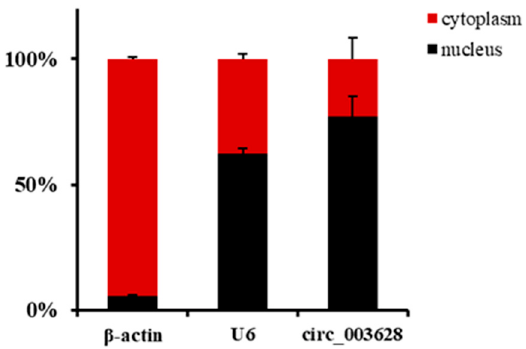
Figure 2. The localization of circ_003628, β -actin and U6 in nuclei and cytoplasm of goat skeletal muscle satellite cells (SMSCs). muscle satellite cells